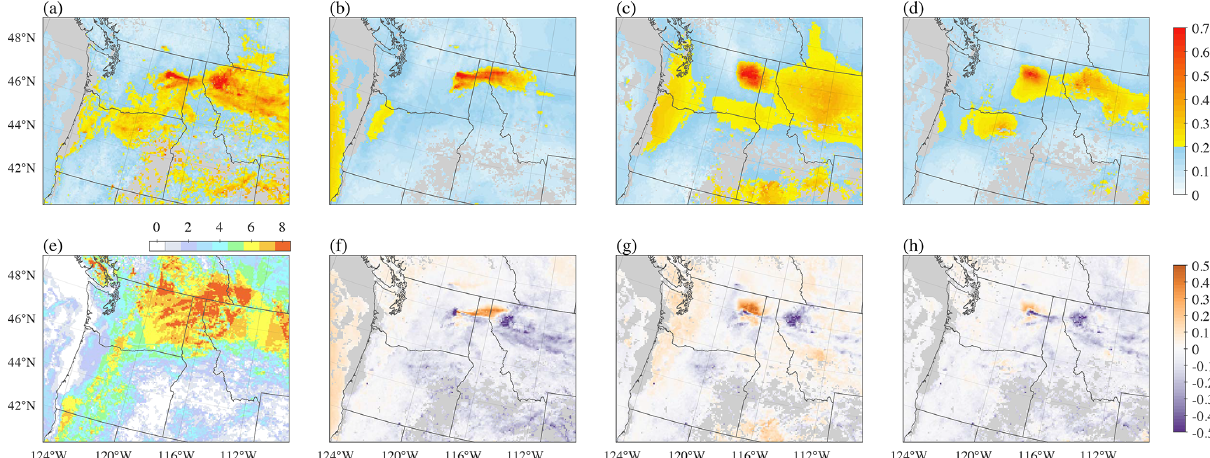
Figure 9. Same as in Fig. 8 but focusing on the inner domain of the simulation. The period averaged here is 6–9 August 2019, focusing on the Williams Flats fire